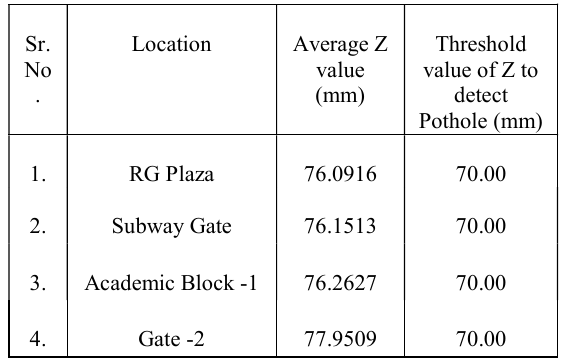
Table 1 . Result of pothole for different locations of RGIPT for Z value.